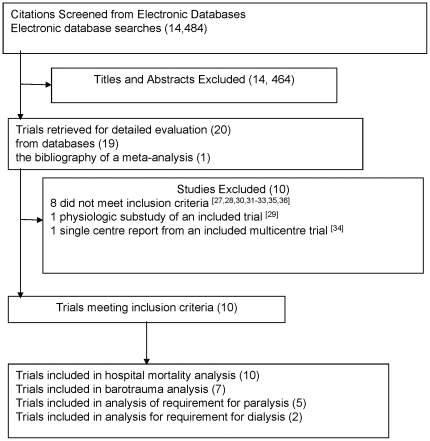
Trials Evaluated During the Systematic Review of the Literature.